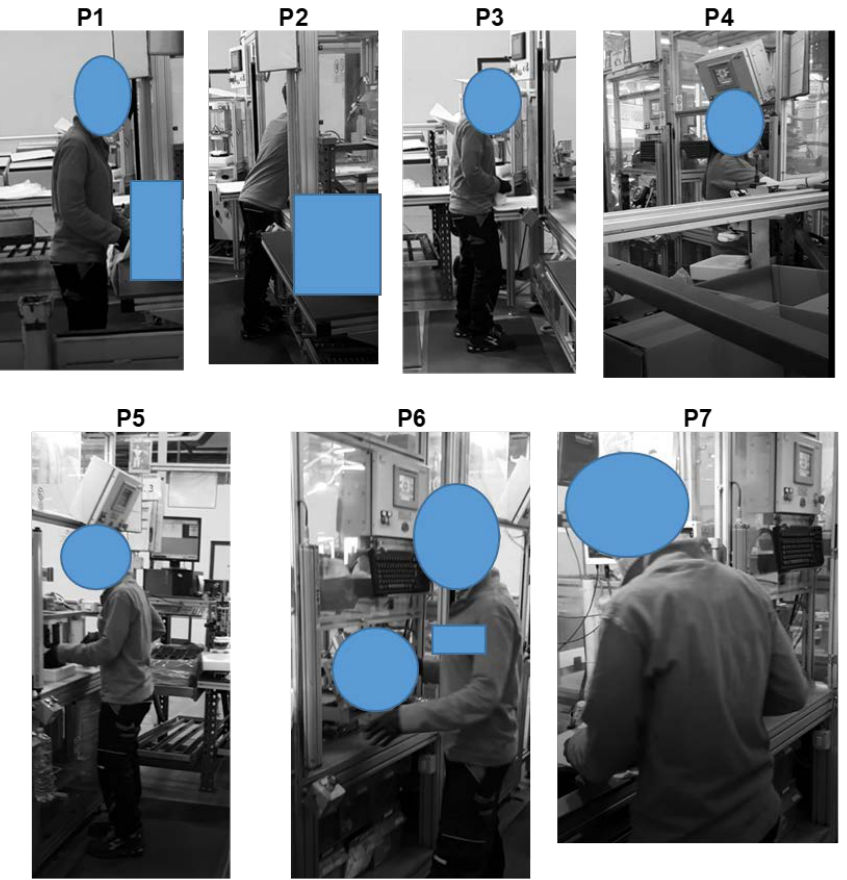
Figure 9. Sequential positions and analyzed postures of the worker in the Alpha workstation.